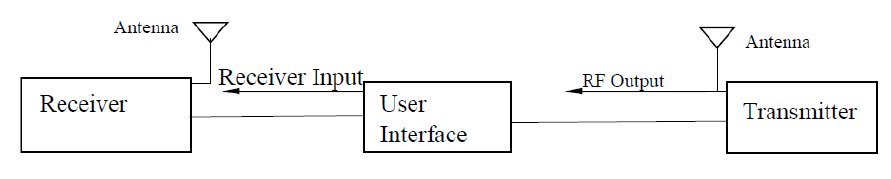
Figure 4. Block diagram of wearable RF hydration